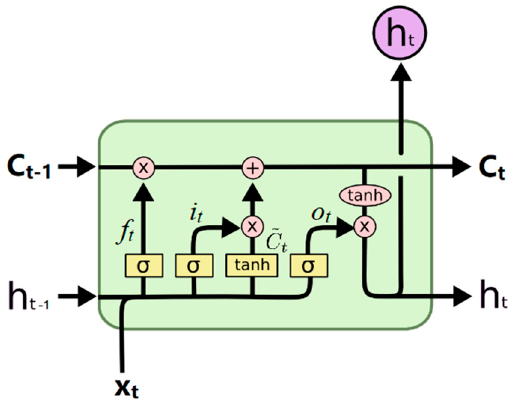
Figure 5. Long short-term memory (LSTM) cell of hidden layer.